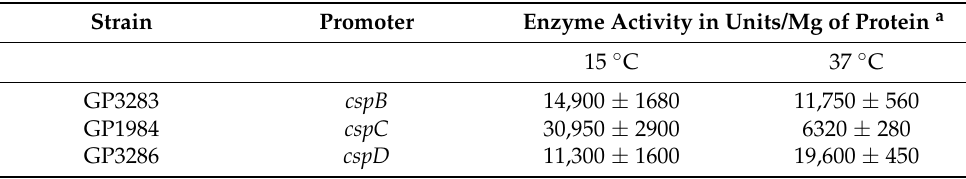
Table 2. Promoter activities of the B. subtilis csp genes.